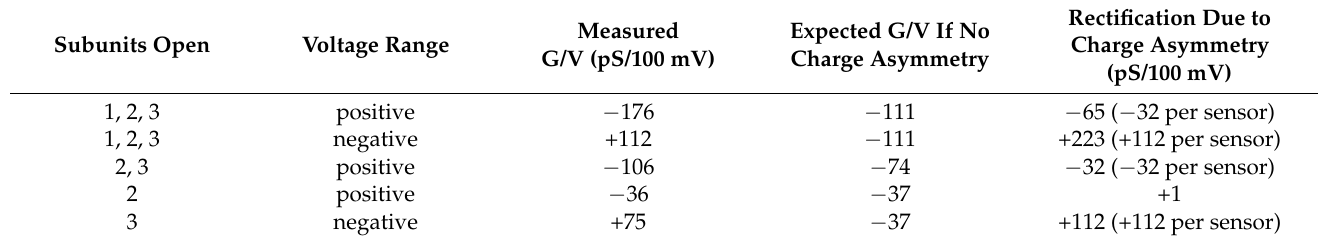
Table 5. Rectification interpreted from the model.